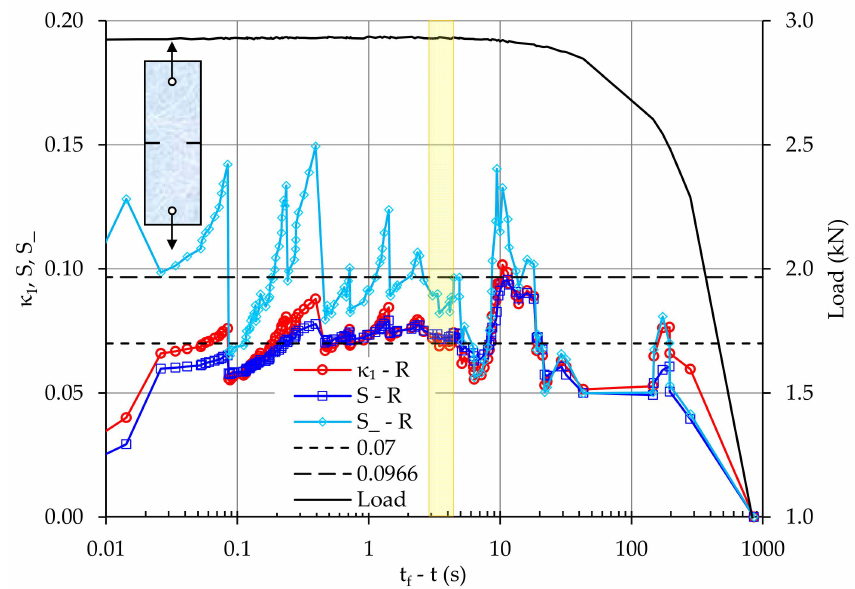
Figure 7. The temporal evolution of the natural time parameters κ 1 , S, S_ and that of the load applied, for the sensor close to the notch from which fracture